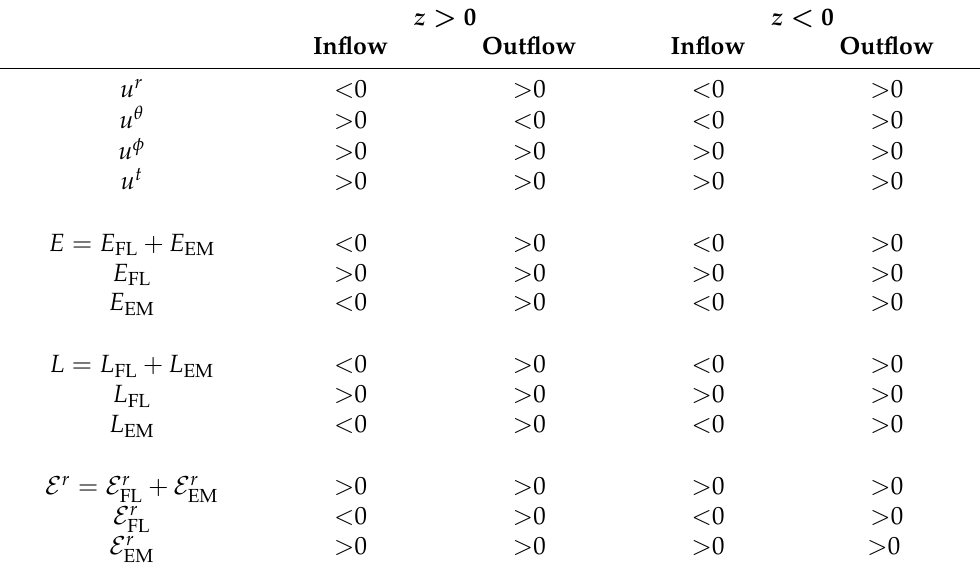
Table 3. Poynting-flux-dominated GRMHD flow properties along large-scale magnetic field threading black hole † . The table is modified from